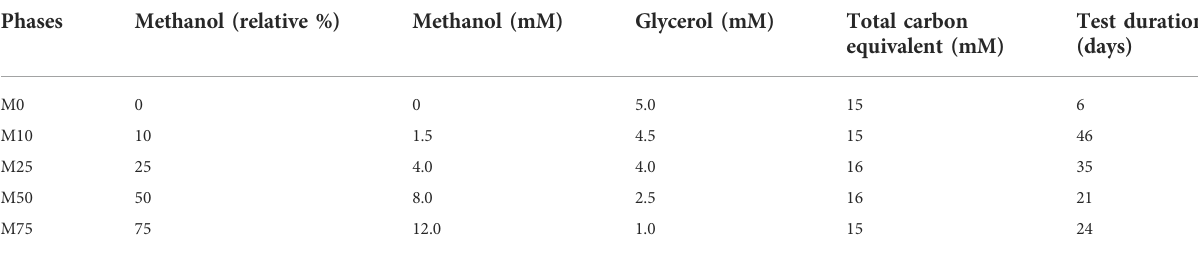
TABLE 1 Ratios of methanol and glycerol in the in fl uent liquors and their combined carbon equivalents. An in fl uent liquor containing only methanol was not tested.